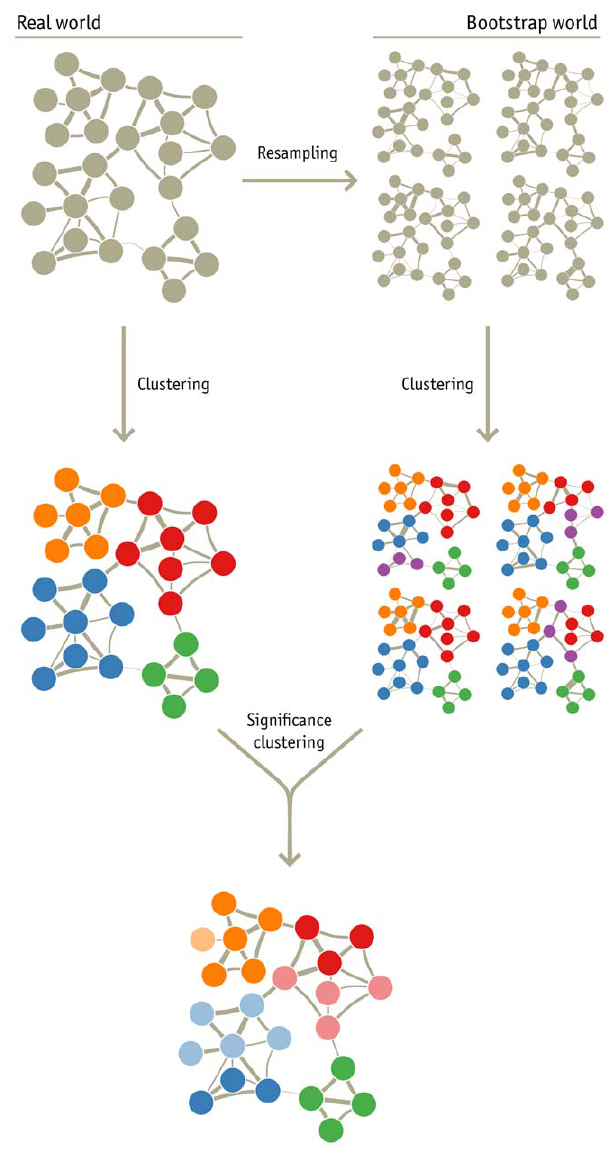
Figure 1. Significance clustering of networks. The standard approach to cluster networks is to minimize an objective function over possible partitions of the network, as in the left side of the diagram. By repeated resampling of the weighted links from the original network, we create a ‘‘bootstrap world’’ of resampled networks. By clustering these as well, and comparing to the clustering of the original network, we can estimate the degree of support that the data provide in assigning each node to a cluster. In the bottom network, the darker nodes are clustered together in at least 95% of the 1000 bootstrap